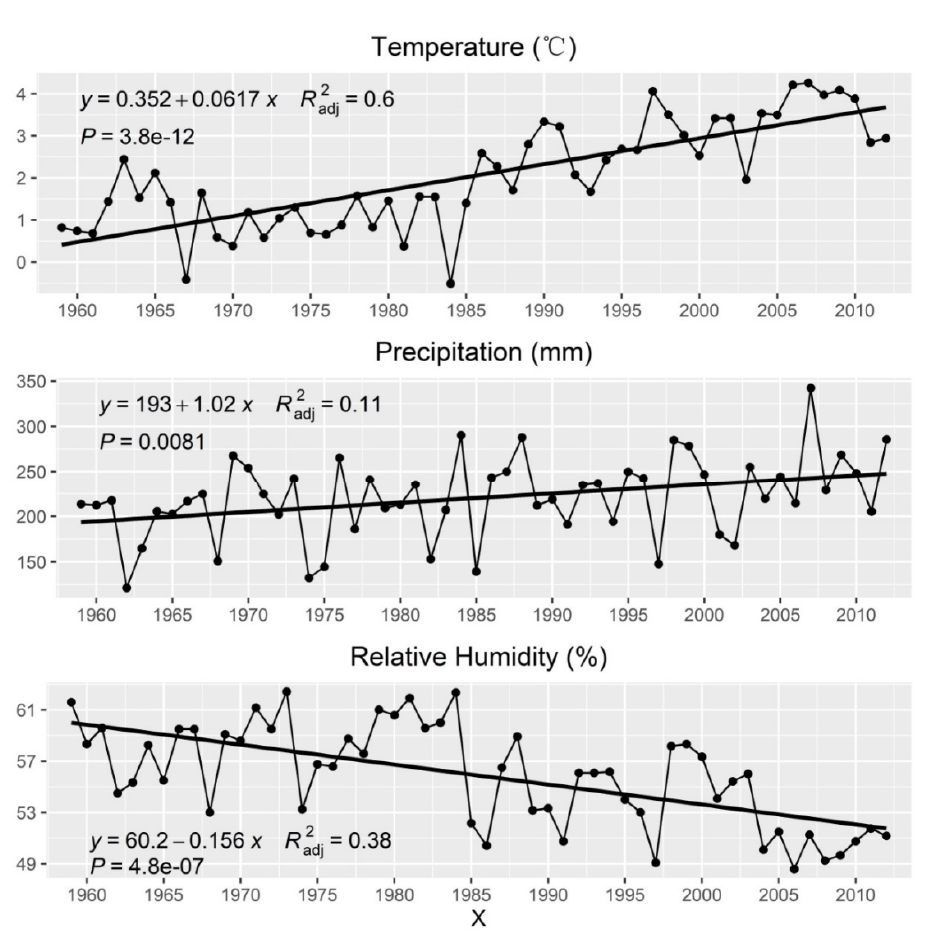
Figure 3. Inter-annual variation trends of mean temperature, annual total precipitation, and relative humidity from 1959–2012 using the records from the Barkol meteorological station. The thick solid lines represent the simulated variation trends by linear regression. P: the significance level of the X coe ffi cient; R 2 adj : the adjusted coe ffi cient of determination. Table 2. Correlation coe ffi cients between temperature, precipitation, R95p, R99p, and relative humidity. Temperature